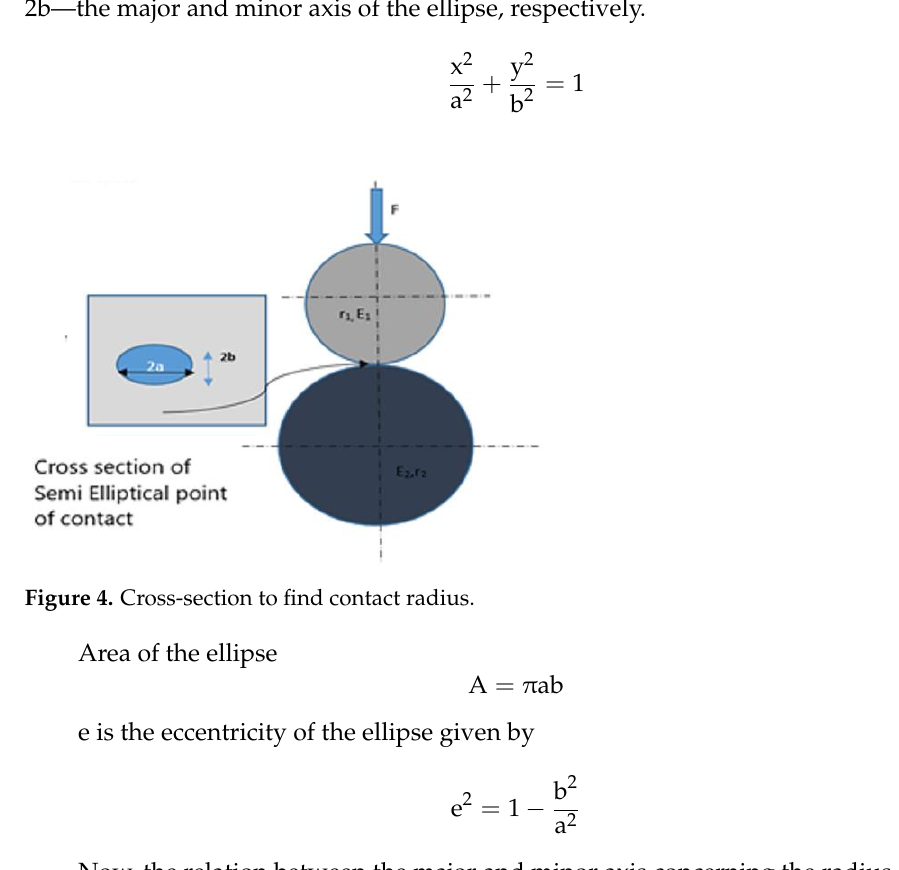
Figure 5. Depth of penetration. 3.3. Integral Calculation of Burnishing Force F(x, y) The elliptical zone is created when the burnishing process force is applied to the workpiece surface. The semi-minor axis of the oval zone that varies from ( – b < y < +b) comes into the picture to calculate the total burnishing force over a contact area. The cross- section view of deformation shown in Figure 6 should be integrated along the minor axis to calculate F. The d epth of penetration ∆ is directly dependent on the burnishing force F(x, y).